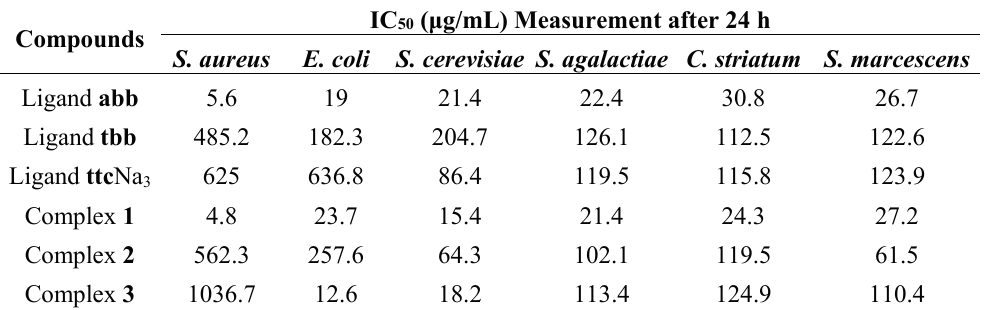
Table 3. Statistical calculation of IC 50 by the STATISTICA software version 10.0 from absorbance values after the application of 0; 7.8; 15.6; 31.3; 62.5; 125 and 250 μ g/mL concentrations of tested